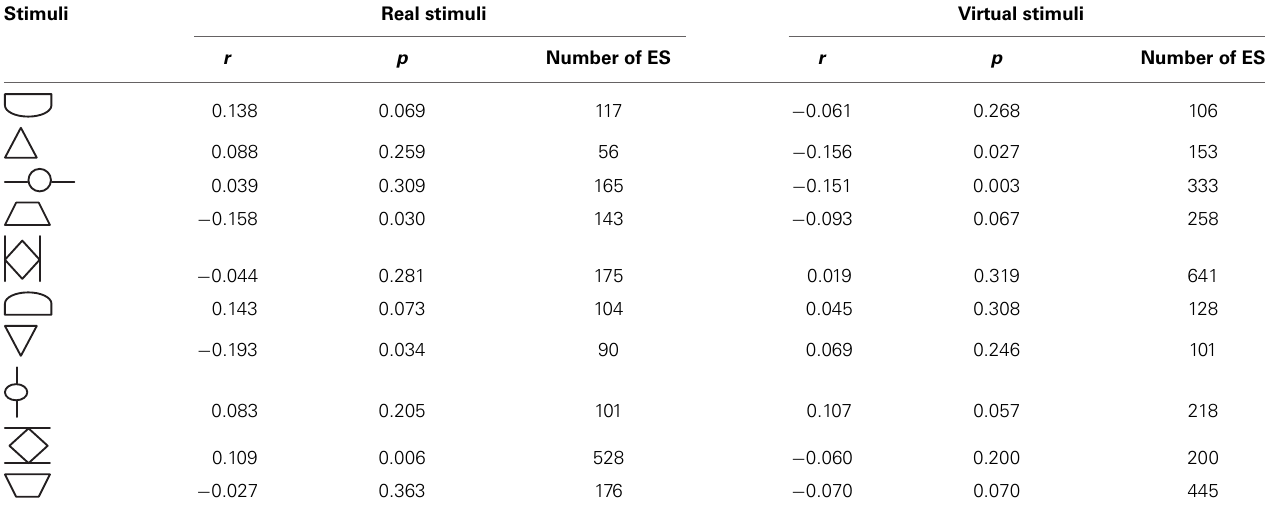
Table 5 | Pearson correlation (one-tailed) between relative exploration time and length of ES (explorative stops in ms) per stimulus for Experiment D (virtual sunken relief) and Experiment E (real sunken relief).